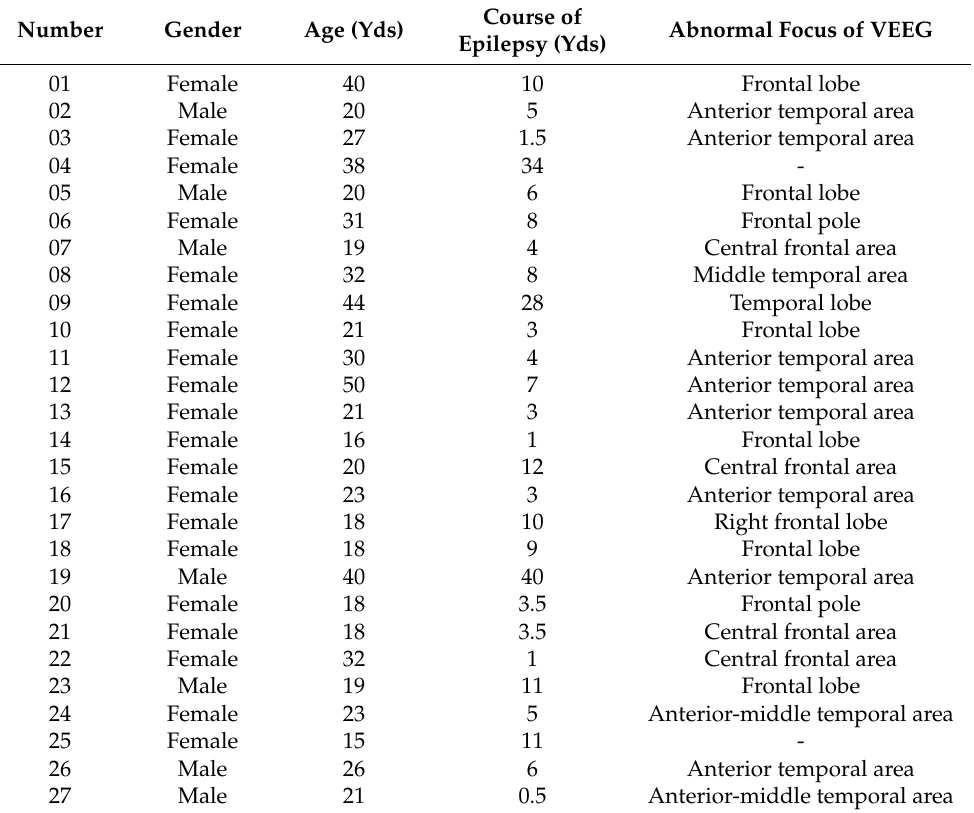
Table 3. PWE participants’